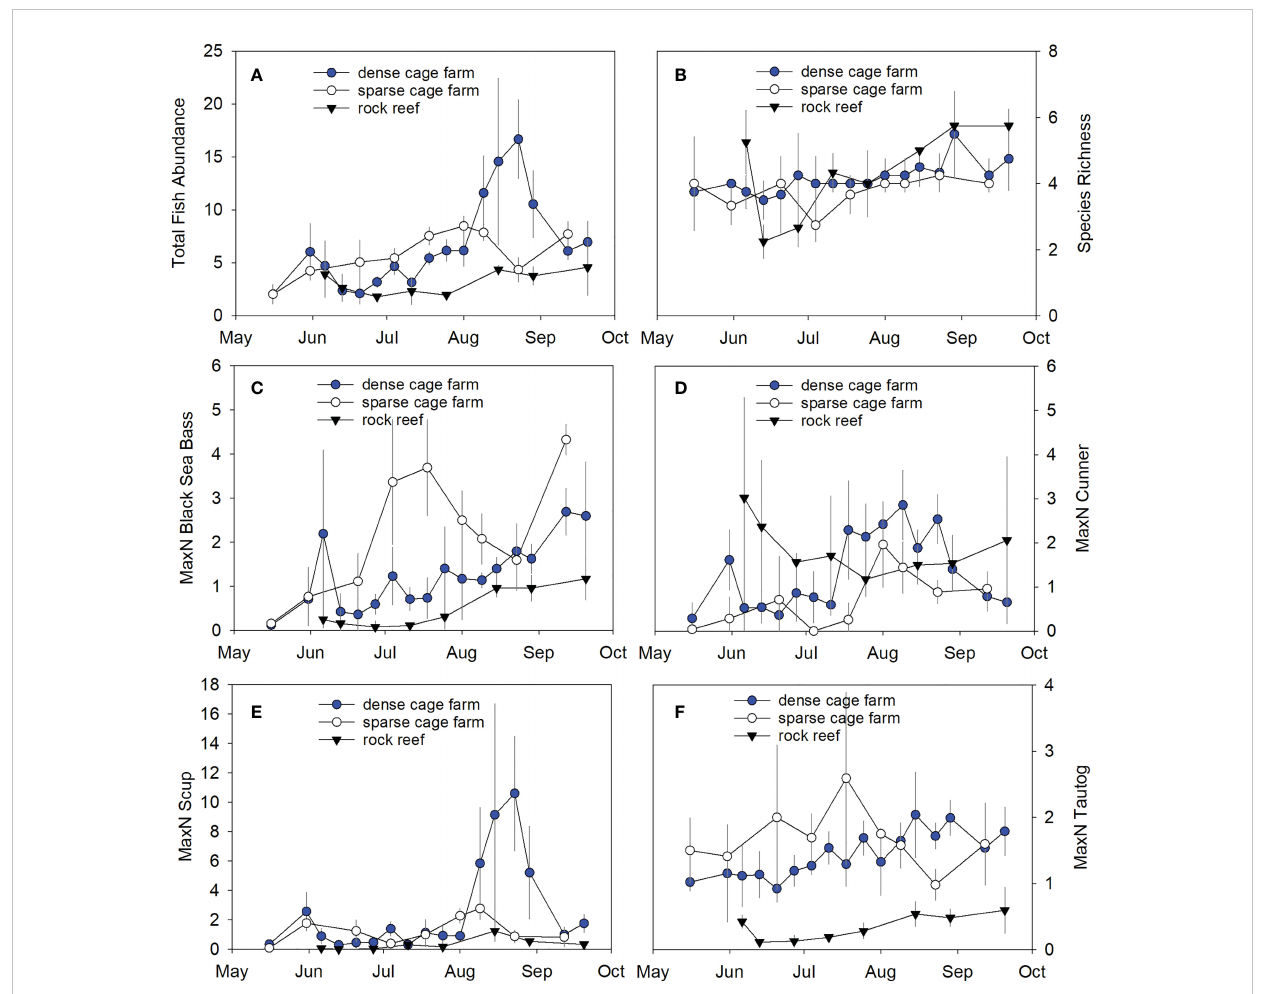
FIGURE 3 Time series of fi sh abundance and species richness at the dense cage farm, sparse cage farm, and rock reef sites between May and September 2018. Symbols indicate mean ± SD. (A) Total fi sh abundance across all species, (B) Species richness, (C) Black sea bass, (D) Cunner, (E) Scup, (F) Tautog.